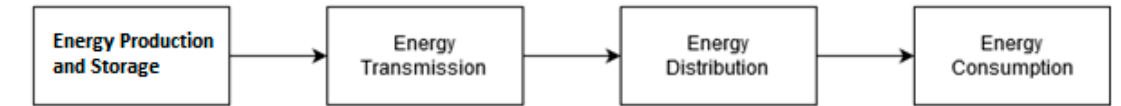
Figure 2. Schematic representation of conventional energy systems.